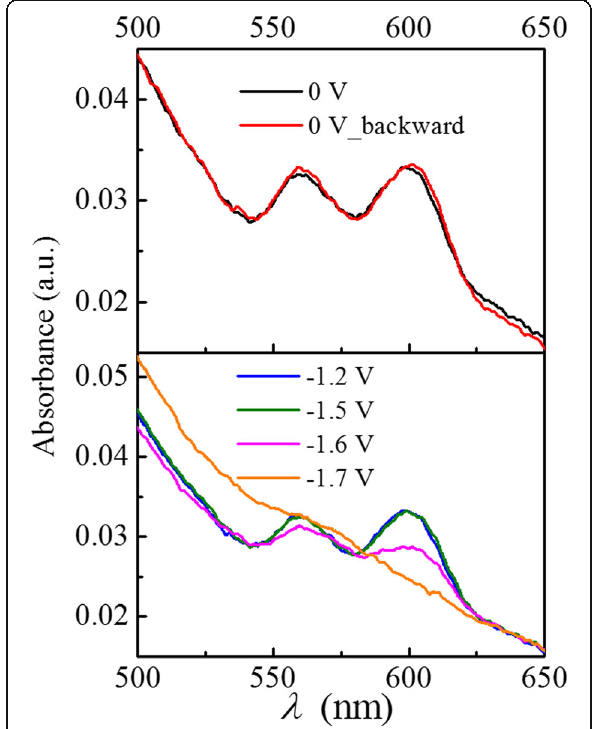
Fig. 2 Absorption spectra under representative applied potentials. 0 V (black), − 1.2 V (blue), − 1.5 V (green), − 1.6 V (pink), − 1.7 V (orange), and 0 V backward (red). Two peaks are assigned to the populations of 1S 3/2 1S e and 2S 3/2 1S e . Absorbance bleach appears when the applied potential exceeds − 1.6 V and recovers after the potential is reset to zero. Note that the charged QD film (at − 1.6 V) shows a redshift with respect to the uncharged film (at 0 V), and the bleach recovers immediately when the potential is reset to 0